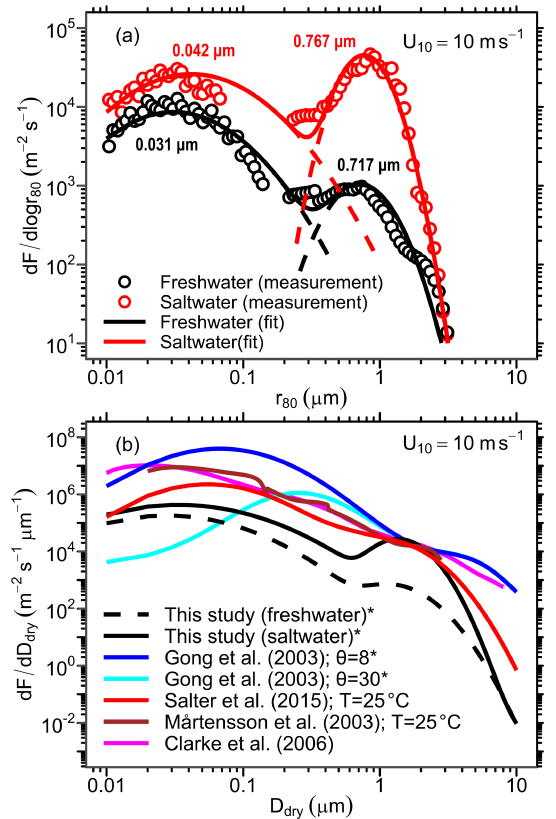
Figure 4. (a) The developed LSSF (freshwater) and SSSF (saltwa- ter) plotted for u 10 = 10ms − 1 . Data points represent the measured emission parameterizations using the MART setup, solid curves represent the lognormal distribution fit, and dashed lines represent each lognormal mode. (b) Comparison of the present LSSF and SSSF with a collection of common SSSFs from the literature for u 10 = 10ms − 1 . Note the change in axes between panels (a) and (b) . ∗ Corrected from their original formulation as a function of r assuming r dry = r 80 /